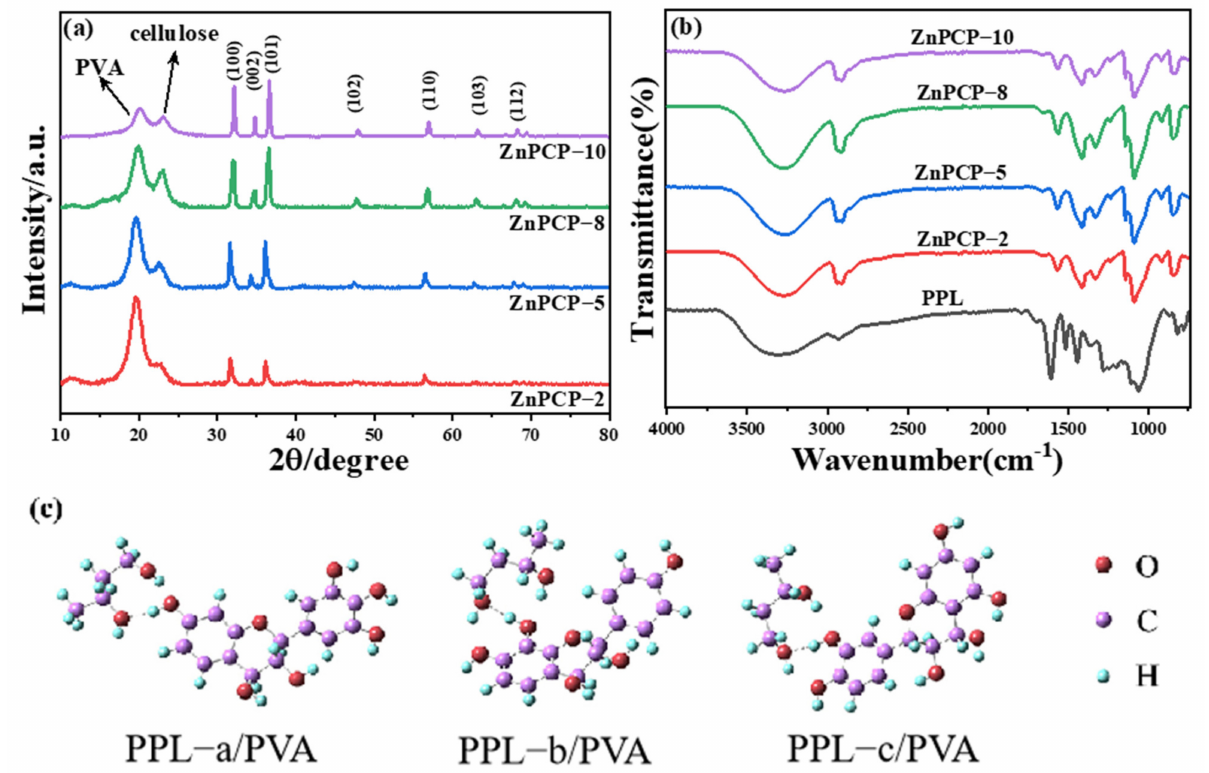
Figure 1. ( a ) XRD patterns of ZnPCP; ( b ) FT − IR spectra of ZnPCP and PPL extract; and ( c ) optimized structures for PPL/PVA